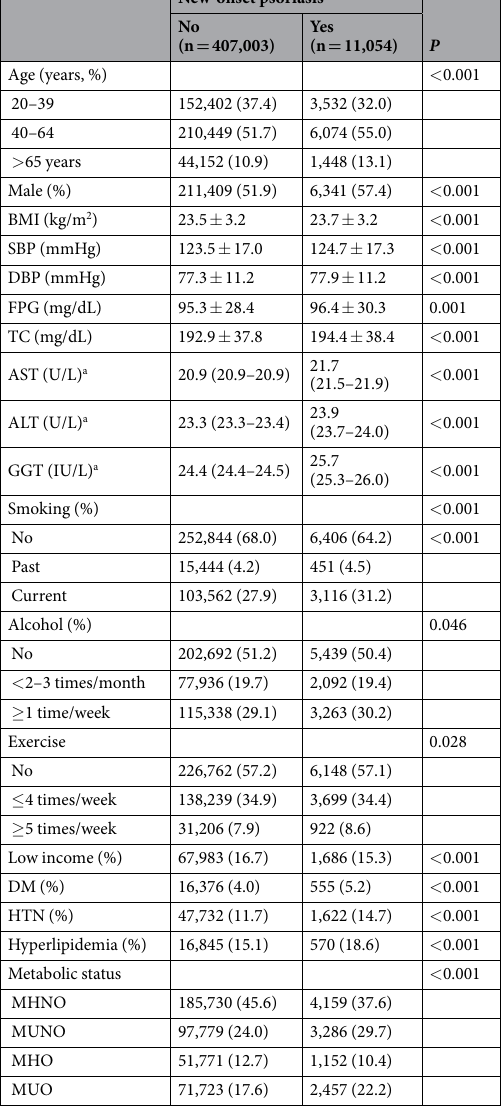
Table 1. Baseline characteristics according to the onset of psoriasis. Data are expressed as mean ± standard deviation, median (95% confidence interval), or number percentage), unless otherwise indicated. BMI, body mass index; SBP, systolic blood pressure; DBP, diastolic blood pressure; FPG, fasting plasma glucose; TC, total cholesterol; AST, aspartate aminotransferase; ALT, alanine aminotransferase; GGT, gamma-glutamyl transferase; MHNO, metabolically healthy, non-obese; MUNO, metabolically unhealthy, non-obese; MHO, metabolically healthy, obese; MUO, metabolically unhealthy, obese; DM, diabetes mellitus; HTN, hypertension. a Data were log-transformed prior to